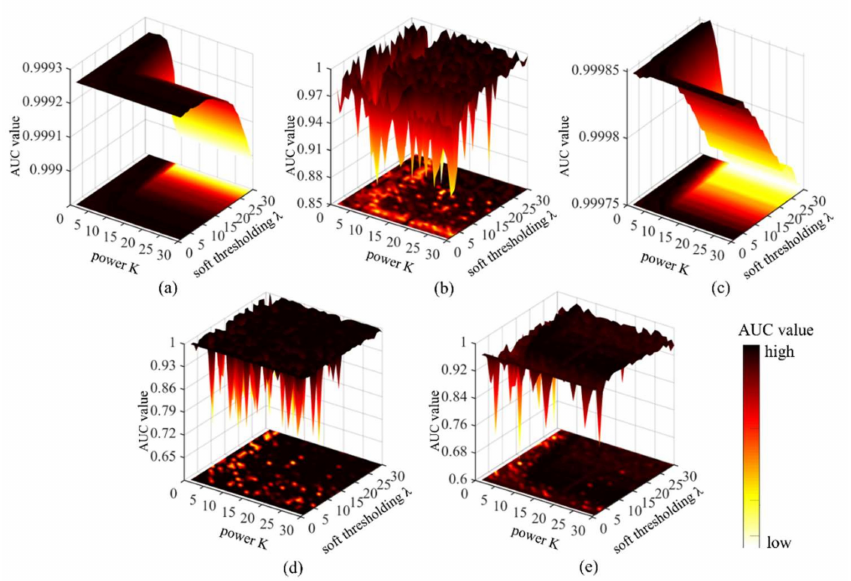
Figure 18. AUC values of GBSAED according to changes in soft thresholding λ and power K: ( a ) Texas Coast Image, ( b ) Belcher Bay Image, ( c ) PaviaC Image, ( d ) San Diego Image, and ( e ) Xiong’an